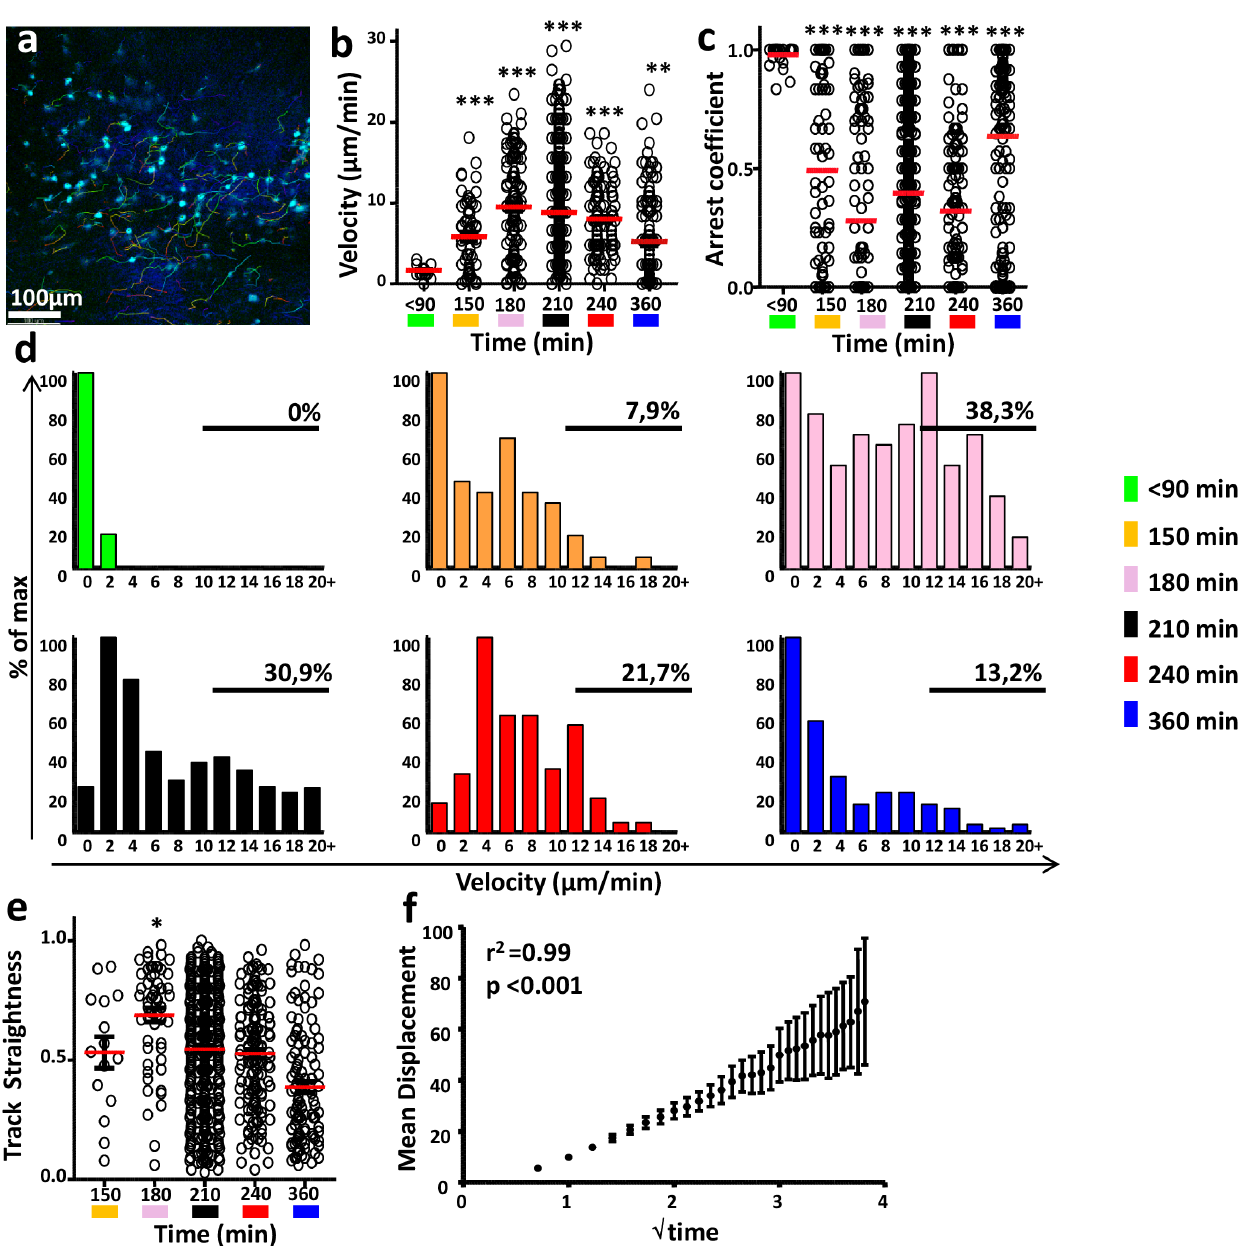
Figure 5. Wound-infiltrating monocytes migrated actively and then stopped within the matrix. ( a ) Representative TPLSM picture of monocyte migratory behavior 210 min after injury of MacBlue 6 CX3CR1 gfp/ + mice. Track pathways of ECFP + cells (cyan) are indicated. Quantification of ECFP + -cell mean velocity ( b ) and arrest coefficient ( c ) at indicated time range after injury. ( d ) Graphs represent cell frequency distribution as a function of their mean velocity at indicated time range after injury. The percentages of cells with a mean velocity higher than 12 m m/min are indicated. ( e ) Quantification of track straightness of ECFP + cells at the indicated time range after injury. ( f ) Representation of the ECFP + -cell mean displacement as a function of the square root of time at 210 min after injury (all quantifications represent a pool of 27 to 781 cells from 3 to 6 different videos performed on 2 to 5 different mice). *p , 0.05; ***p , 0.001.